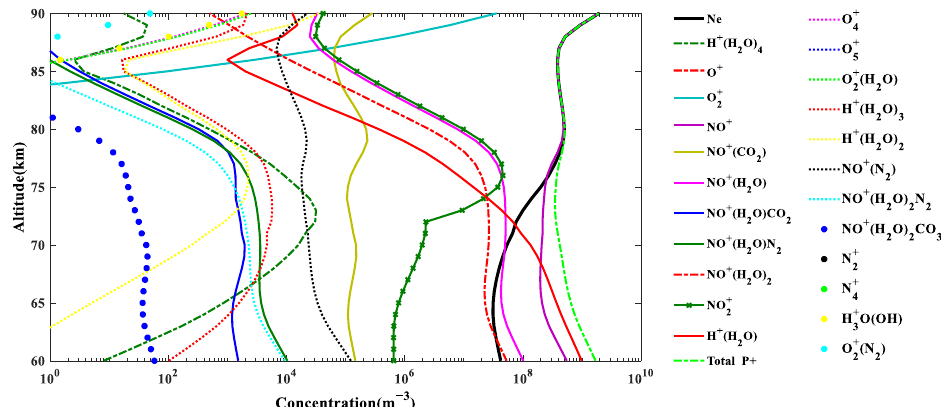
Figure 3. Distribution of positive ions, total positive ions, and electrons at 12:00 LT.